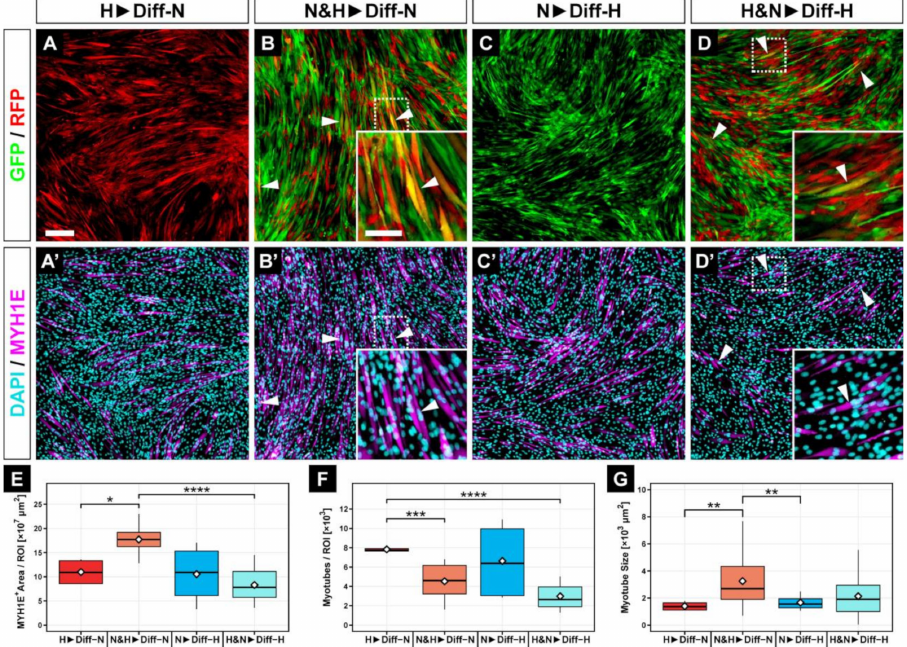
Figure 4. Representative fluorescence microscope images for GFP/RFP ( A – D ) and for MYH1E and DAPI ( A’ – D’ ). C2C12 RFP , hypoxic-conditioned cells transferred to 21% O 2 (H (cid:183) Diff-N, A , A’ ) or mixed C2C12 cultures in 2% O 2 (H&N (cid:183) Diff-H, D , D’ ) showed less myoblast fusion compared with normoxic cells differentiated in hypoxia (N (cid:183) Diff-H, C , C’ ) or mixed C2C12 cultures differentiated in normoxia (N&H (cid:183) Diff-N, B , B’ ). Moreover, C2C12 GFP and C2C12 RFP cells were able to fuse in mixed culture settings ( B , D , arrowheads). While the mixed group had the largest MYH1E + area ( E ) and the greatest myotube size at 21% O 2 ( G ), the myotube number did not increase with mixing of the two cell populations ( F ). Scale bars: 200 µ m. Bar plots represent the median, quartiles, range, and mean (white diamond). * p ≤ 0.05. ** p ≤ 0.01. *** p ≤ 0.001. **** p ≤ 0.0001. However, when we compared hypoxic-preconditioned cells differentiated in hypoxia (H (cid:183) Diff-H) (Figure 3D,D’) or normoxia (H (cid:183) Diff-N) (Figure 4A,A’), we detected a 5% and 19% increase in the efficiency of myogenic differentiation and the number of myotubes, respectively, and a 13% larger myotubes size in the H (cid:183) Diff-H group compared with H (cid:183) Diff- N myotubes (Figure